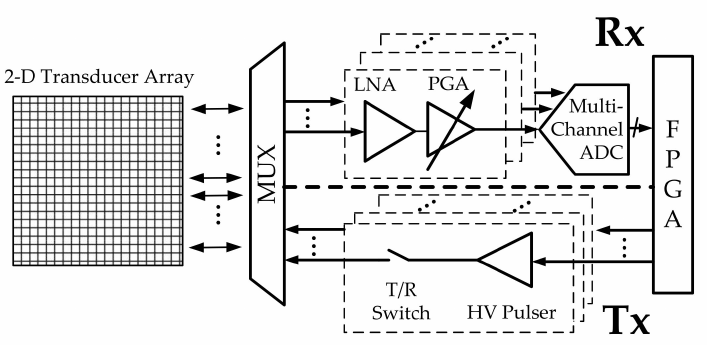
Figure 1. System diagram of an ultrasound imaging system. The arrows indicate the electronic signal flow in both Tx and Rx channels. Components surrounded by a dashed box are usually integrated into a single chip. A multi-channel ADC quantifies signals from multiple chips and sends them to